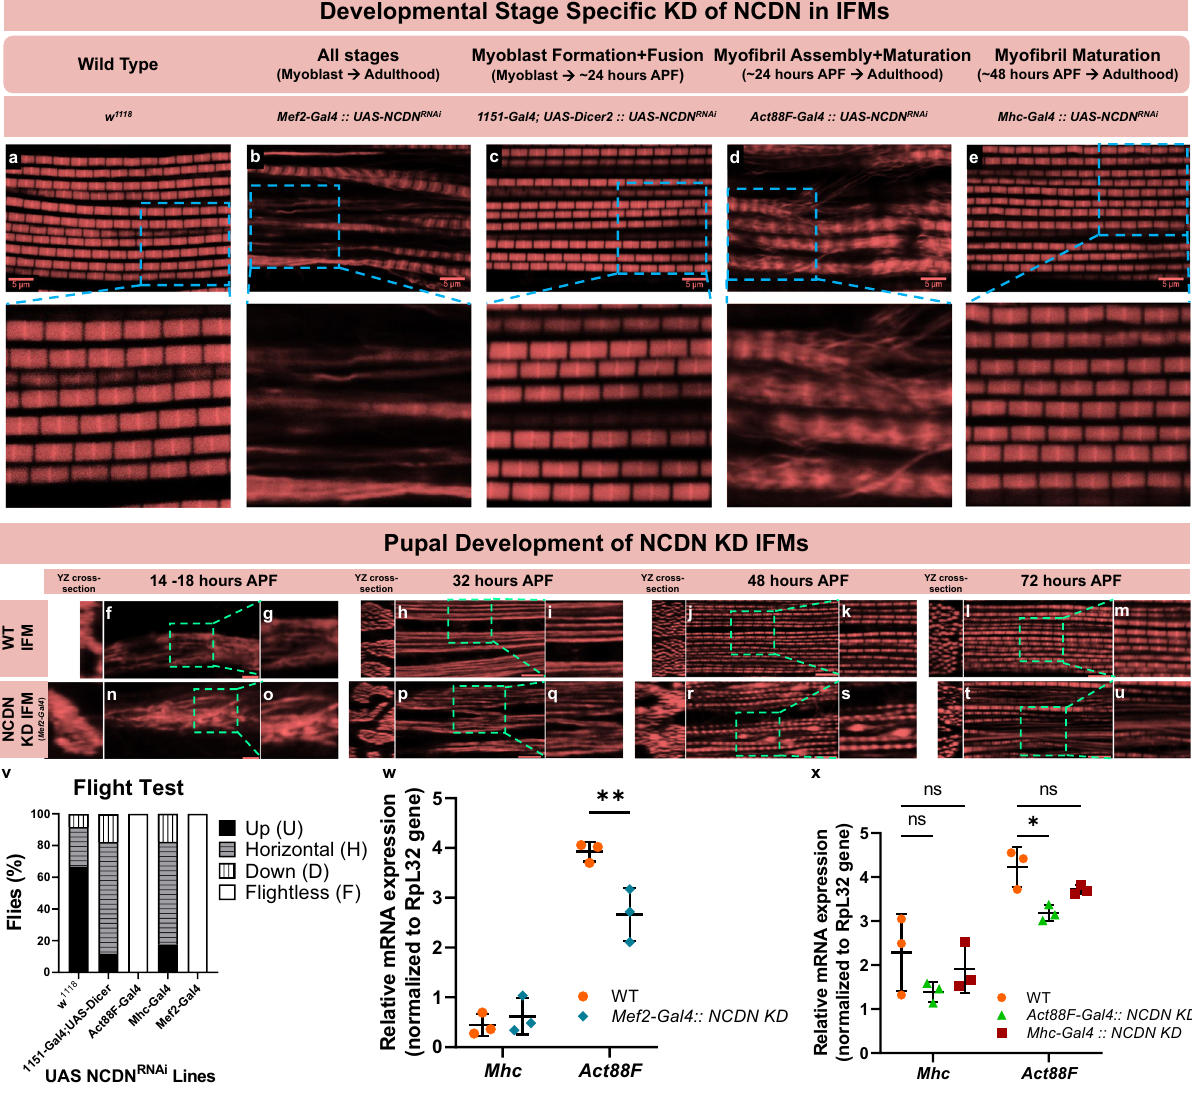
Fig. 5 Neurochondrin regulates sarcomere branching during myo fi bril assembly. a – e Confocal microscopic images of adult indirect fl ight muscle (IFM) actin after different developmentally timed knockdowns (KD) of neurochondrin (NCDN). Blue dotted lines highlight the region shown in inset (lower panels). f – u Confocal microscopy images of IFM actin during pupal development in wild type and NCDN KD fl ies. Cross-section images are shown at the left of each image and dotted lines highlight the zoomed-in regions shown to the right of each image. Representative of cells from three fl ies. Scale bars: 5 µ m. v Flight test results in wild type (WT) and different developmentally timed NCDN KD fl ies. w IFM actin (Act88F) and myosin (Mhc) relative RNA expression levels in adult WT and Mef2-Gal4::UAS-NCDN RNAi fl ies. x IFM Act88F and Mhc relative RNA expression levels in adult WT, Act88F-Gal4::UAS- NCDN RNAi , and Mhc-Gal4::UAS-NCDN RNAi fl ies. Bars represent overall mean ± SE from three samples (individual points) of 20 pooled thoraces per group. Asterisks (*): Signi fi cantly different between groups ( w two-sided, independent t test, x one-way ANOVA with Tukey ’ s HSD post hoc test, P <